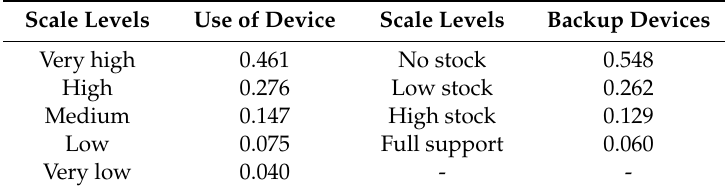
Table 13. Weightings of the scale levels of the descriptors of Impact of operation.